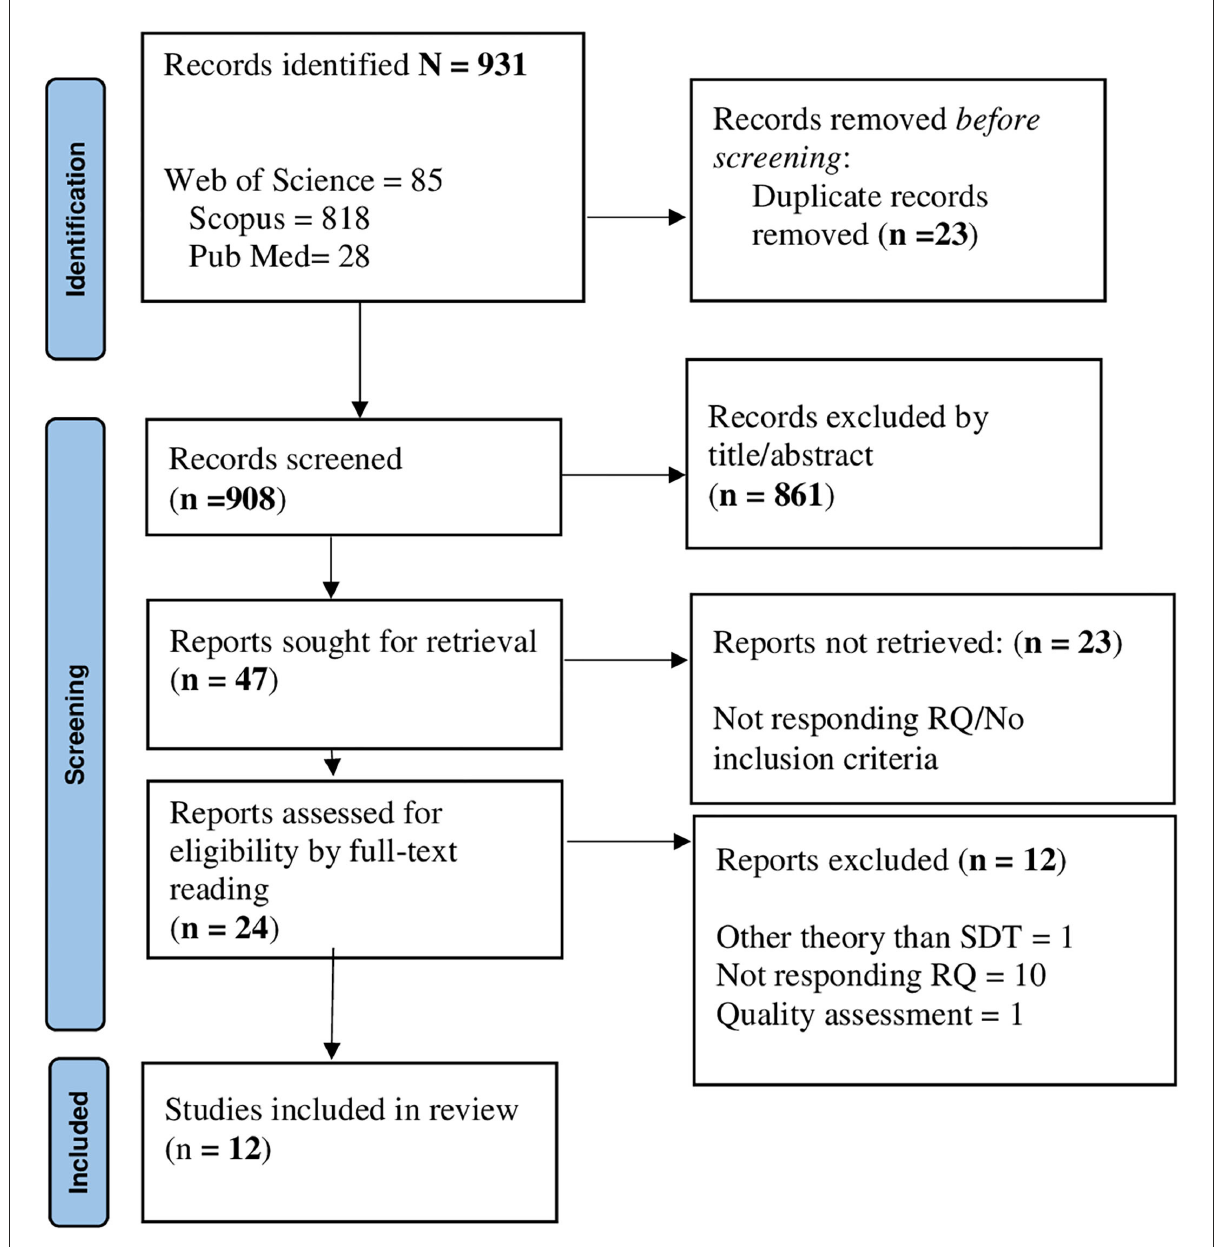
FIGURE3 PRISMA flowchart for the factors are associated with HE students’ academic